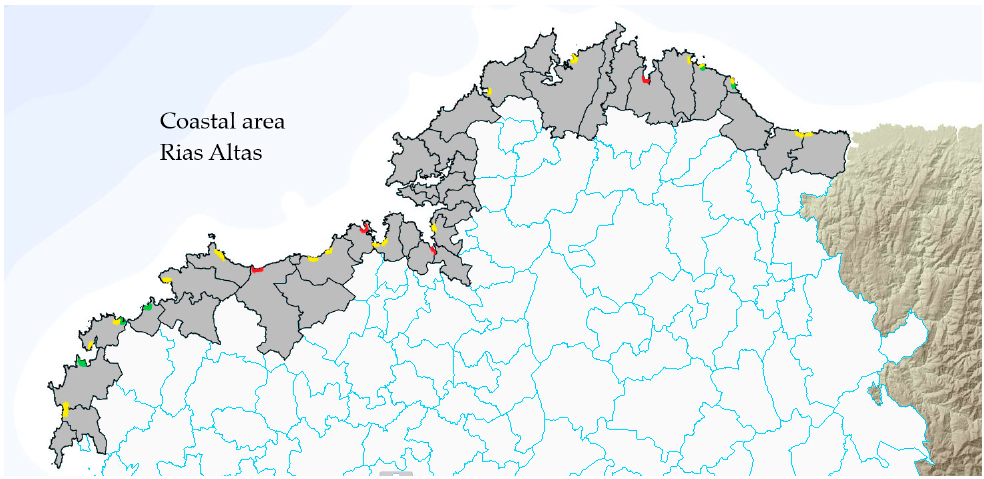
Figure 6. Tourism vulnerability of at risk beaches in Rias Altas. Green: Beaches with low tourism vulnerability; yellow: medium vulnerability; red: high vulnerability.